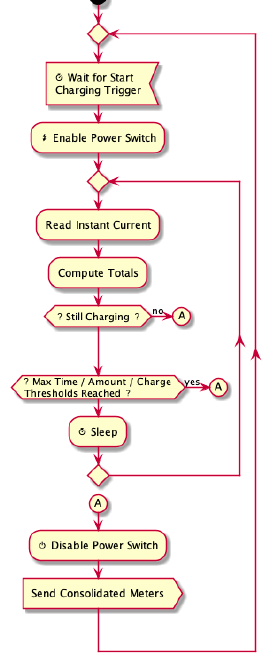
Figure 16. CS charging process activity diagram.